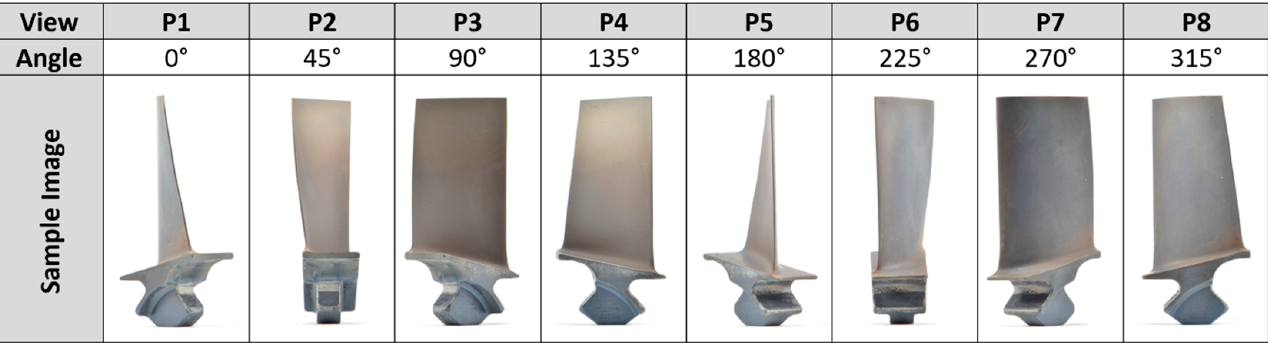
9 of 29 Figure 5. Sample blade defects: ( A ) nick on leading edge, ( B ) dent on trailing edge, ( C ) nick on leading edge, ( D ) teared-